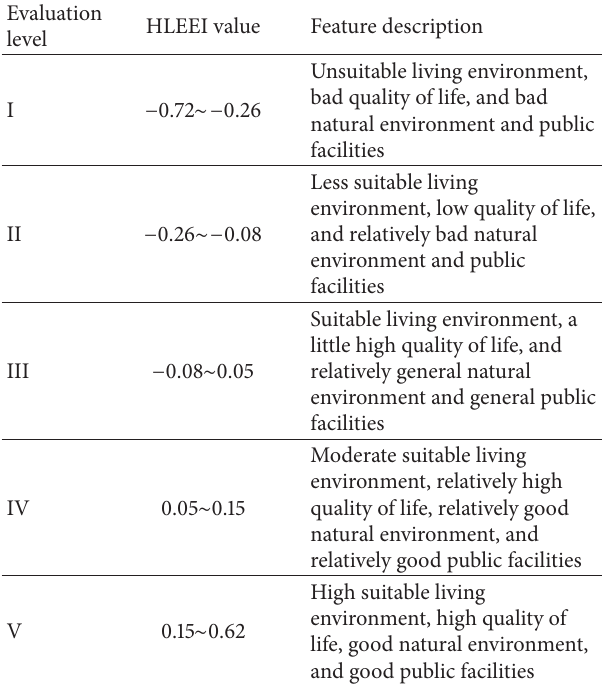
Table 2: Human living environmental evaluation grade in